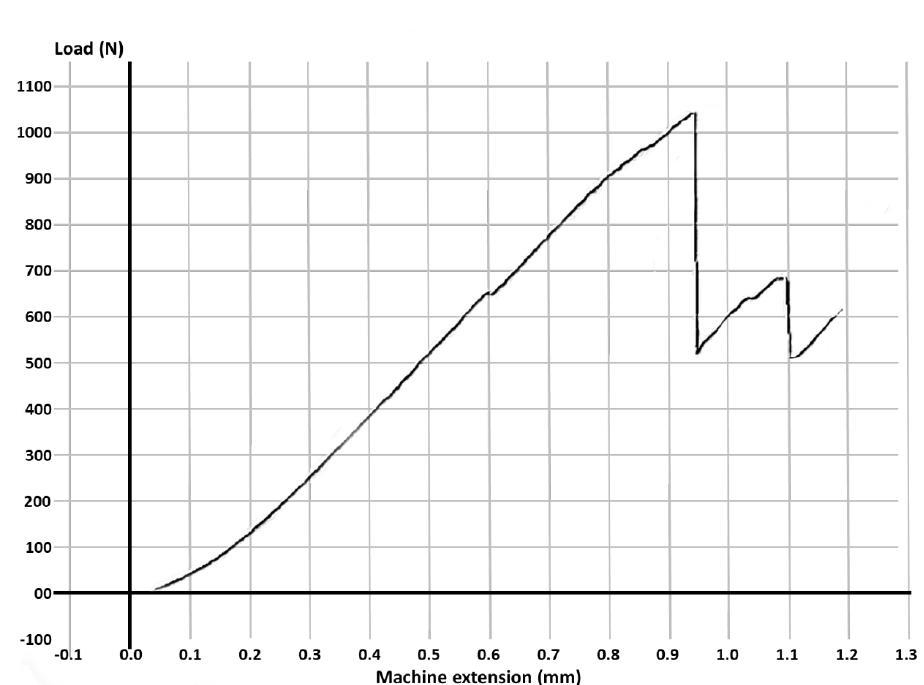
Figure 2. The maximum value of the force at which the most resistant molar from Group A failed.